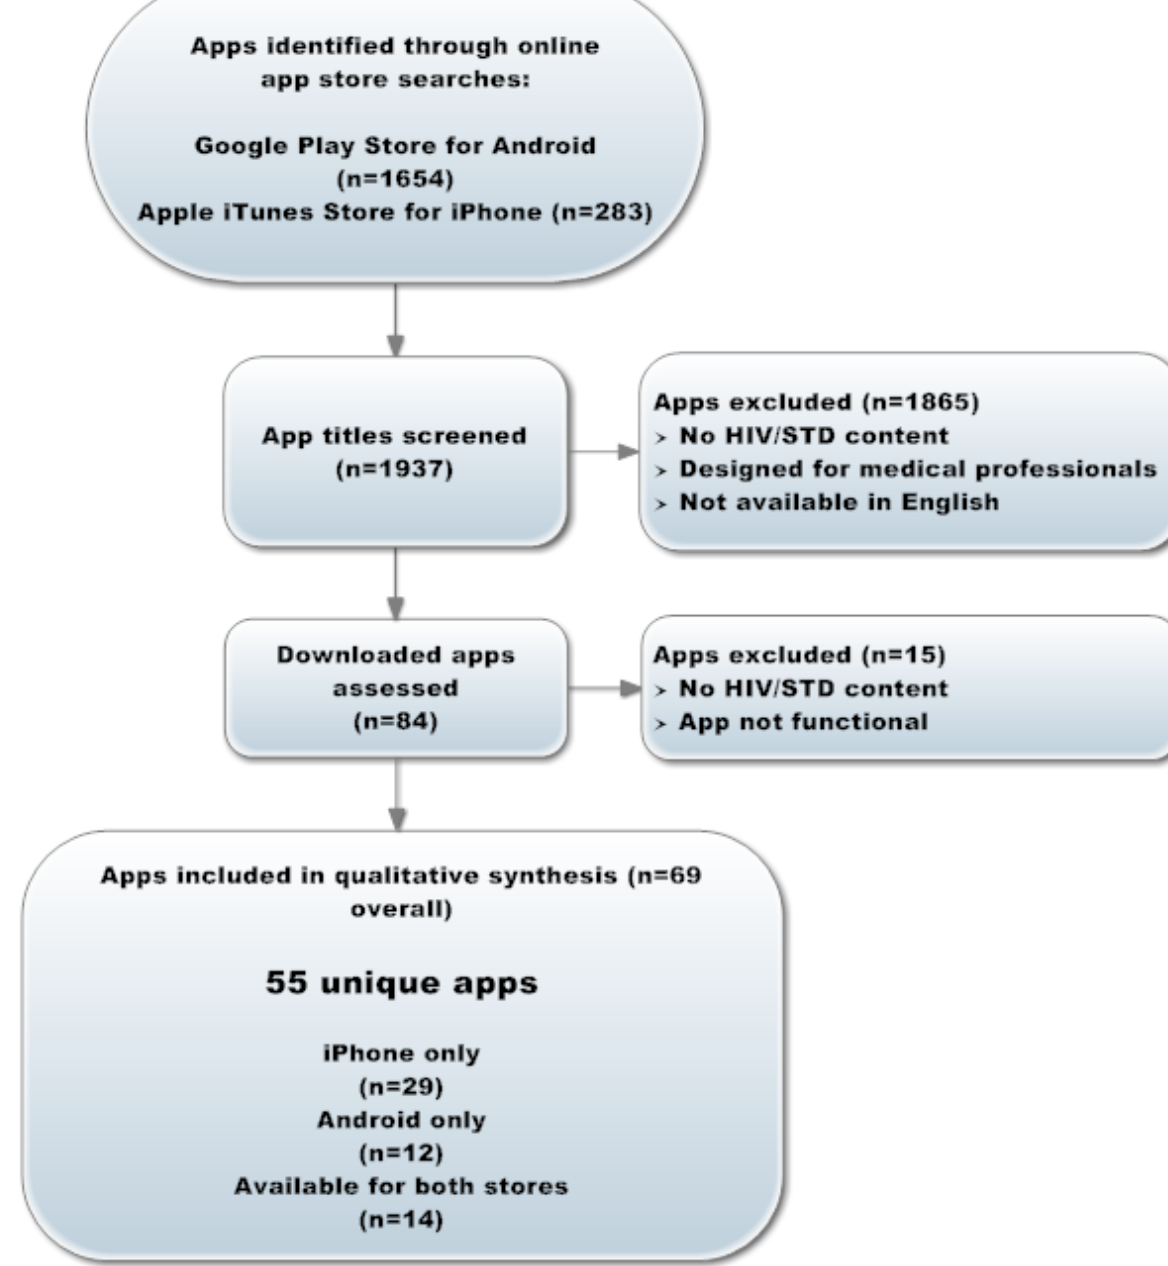
Figure 1. Search and screening process for HIV/STD-related